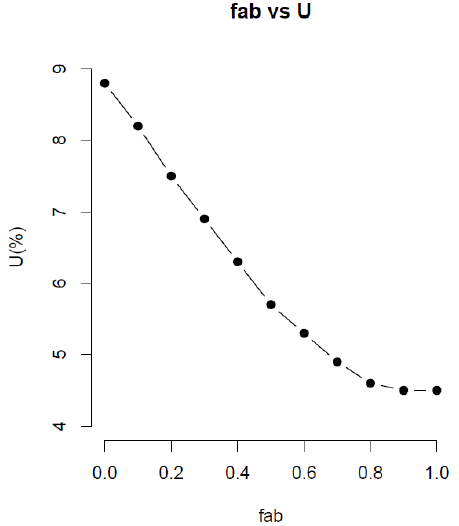
ff ect of f ab on the values of U for the bootstrap Figure 3. The effect of f ab on the values of U for the bootstrap method. Figure 3. The e